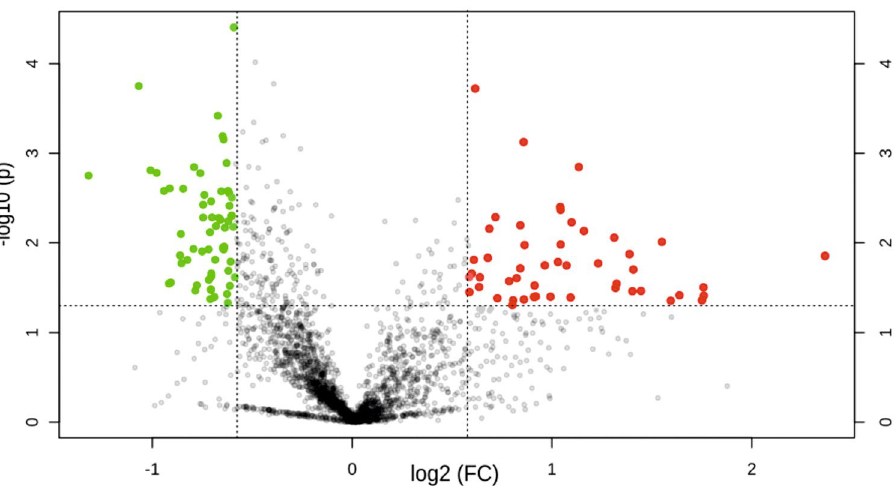
Figure 4. Volcano plot of proteins identified in iTRAQ experiment. Red dots represent up-regulated proteins with > 1.5 fold change, green dots represent down-regulated proteins with < 0.66 fold change. House-keeping proteins with expression fold between 1.5 and 0.66 is shown as greydots. FC indicates Fold